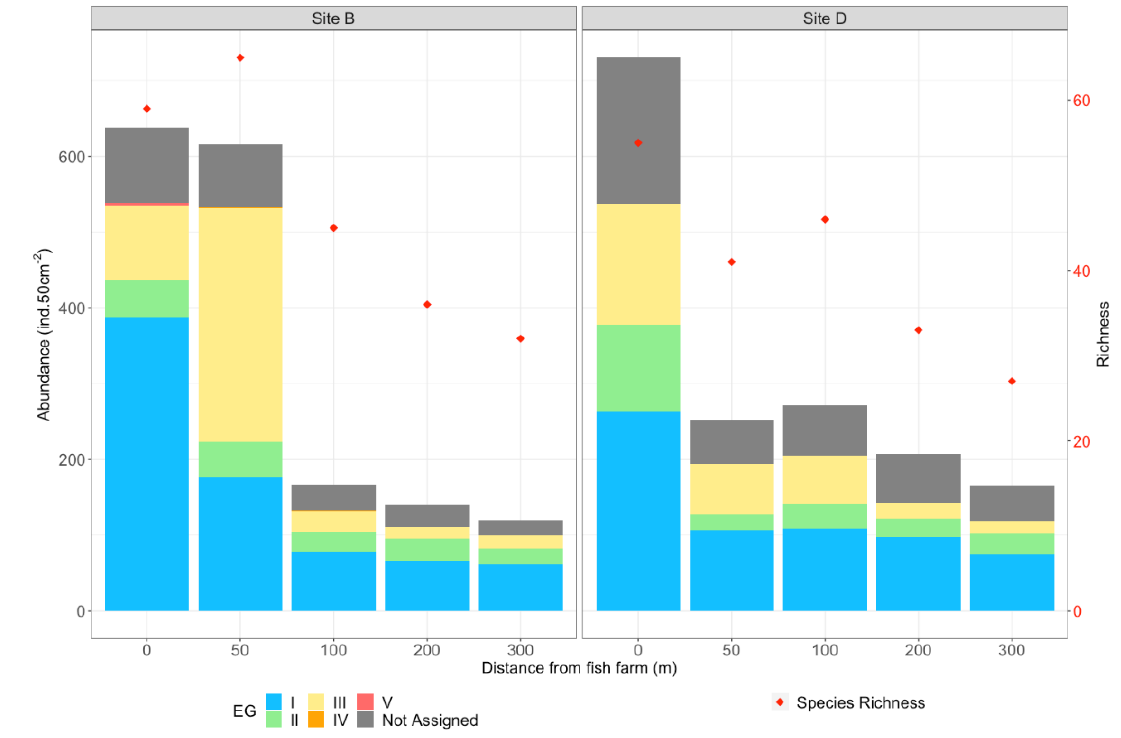
Figure 4. Species richness and living foraminiferal abundances (ind.50 cm − 2 ) for each station sampled and for each ecological group (EG) [47] to calculate Foram-AMBI.